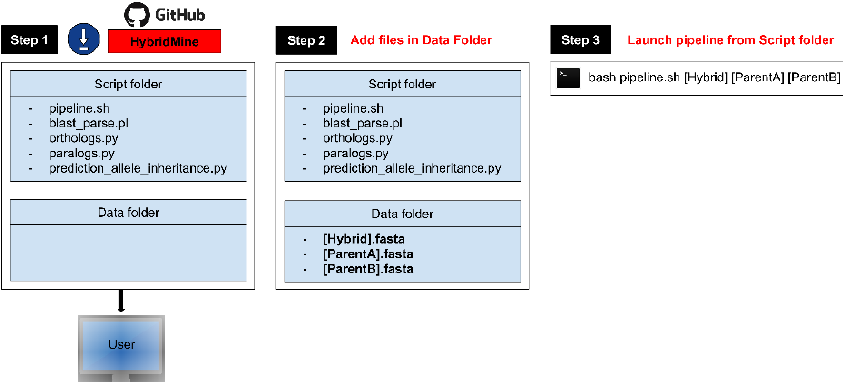
Figure 5. HybridMine usage. Step 1: Users to download HybridMine from its GitHub repository. Step